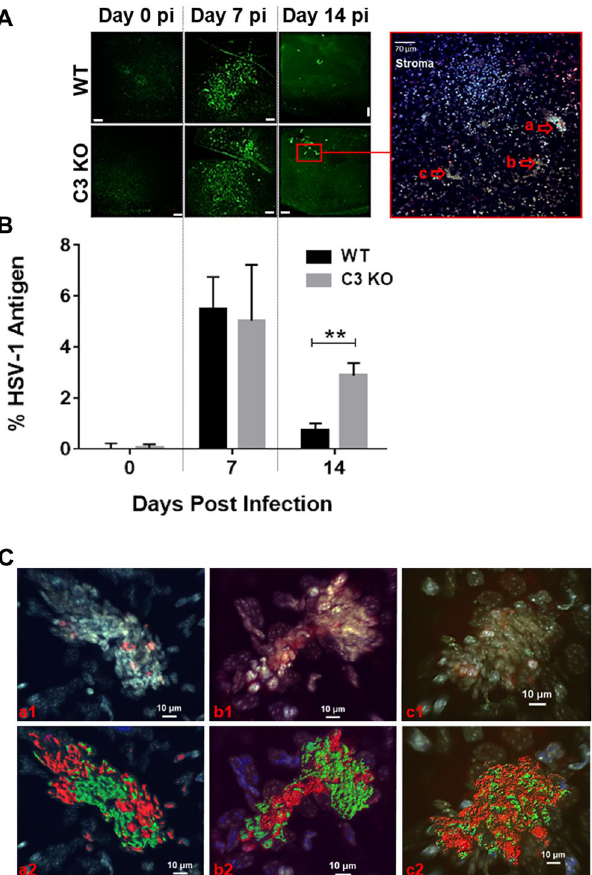
Figure 7. Clearance of HSV-1 antigen following acute ocular infection is hindered in C3 KO mouse corneas. HSV-1-infected WT and C3 KO mice were euthanized by exsanguination at day 7 or day 14 pi. Corneas were surgically removed and processed for immunohistochemistry using anti-HSV-1 and anti-CD45 antibodies as described in Materials and methods section. ( A ) Representative confocal microscopy images of flat mount cornea preparations from 0 (non-infected), 7 and 14 dpi of WT and C3 KO mouse corneas. HSV-1 antigen expression is displayed in the stroma in green. No antigen was detected in the epithelial layers. Magnification was 10× ( Z -stack = 25 slices, 4.77 µm step size, Scale bar: 100 μm). Red square is an amplification of one particular region of C3 KO at 14 dpi, deeper focus was made to amplify the stroma excluding the corneal- epithelium (Z-stack = 40 slices, 1.77 µm step size, Scale bar: 70 μm). Right, three HSV-1antigen reactivity areas are highlighted (a, b and c). Cells in red are CD45 + and cells in green are HSV-1 + with DAPI staining in blue. ( B ) Metamorph quantification of the cornea area positive for HSV-1 antigen. Horizontal bars depict mean of percentage threshold area positive for anti-HSV-1 positive spots ± SEM (* p < 0.05 comparing the two groups as determined by unpaired, two-tailed t-test comparison, n = 3 per treatment, two repetitions). ( C ) Three dimensional reconstruction of stromal image in panel A highlighted by arrows a, b, and c are shown using IMARIS software depicted as a1, b1 and c1 and a2, b2 and c2 (Z-stack = 100 slices, 0.55 µm step size, Scale bar: 10 μm). Series 1 includes CD45, HSV-1 antigen, and DAPI stained profiles. Series labeled “2” includes CD45 and HSV-1 antigen staining. CD45 + cells are in green, HSV-1 + cells are in red, and blue is DAPI